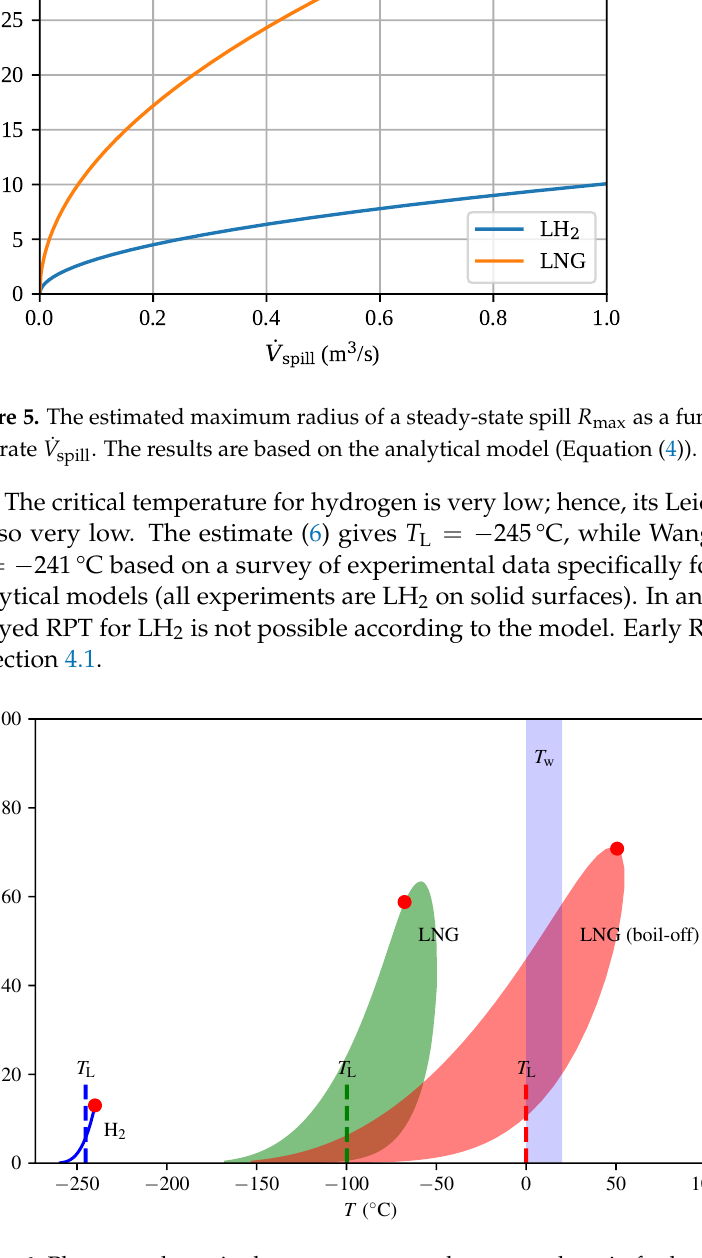
Figure 6. Phase envelopes in the temperature and pressure domain for hydrogen and natural gas with initial and boil-off compositions. The two-phase regions are shaded and the red dots are the respective critical points. The Leidenfrost temperatures are indicated by dashed